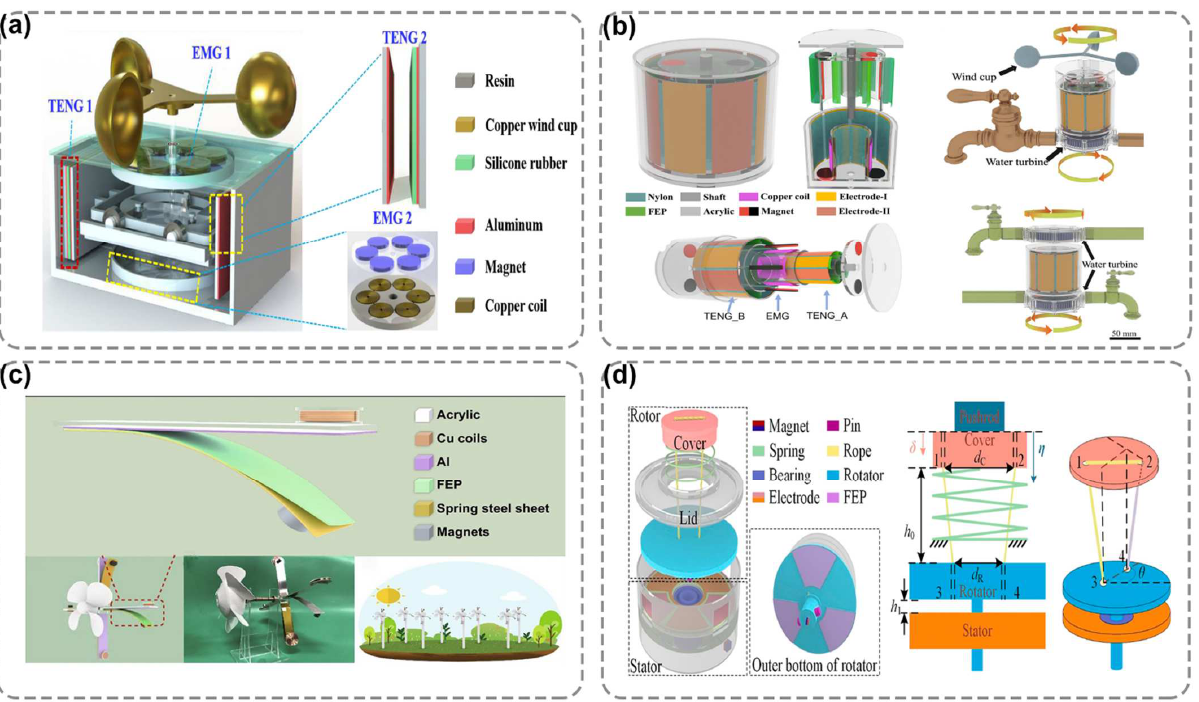
Figure 9. Hybrid TENGs combined with EMG and TENG. ( a ) The structure of the TEHG. Reproduced with permission of [88], Copyright 2019, Elsevier. ( b ) Structural design of the MCNG. Reproduced with permission of [86], Copyright 2021, Elsevier. ( c ) Schematic illustration of the W-HNG. Reproduced with permission of [36], Copyright 2020, Springer. ( d ) Structure and working principle of the IC-TENG. Reproduced with permission of [87], Copyright 2021, Elsevier.